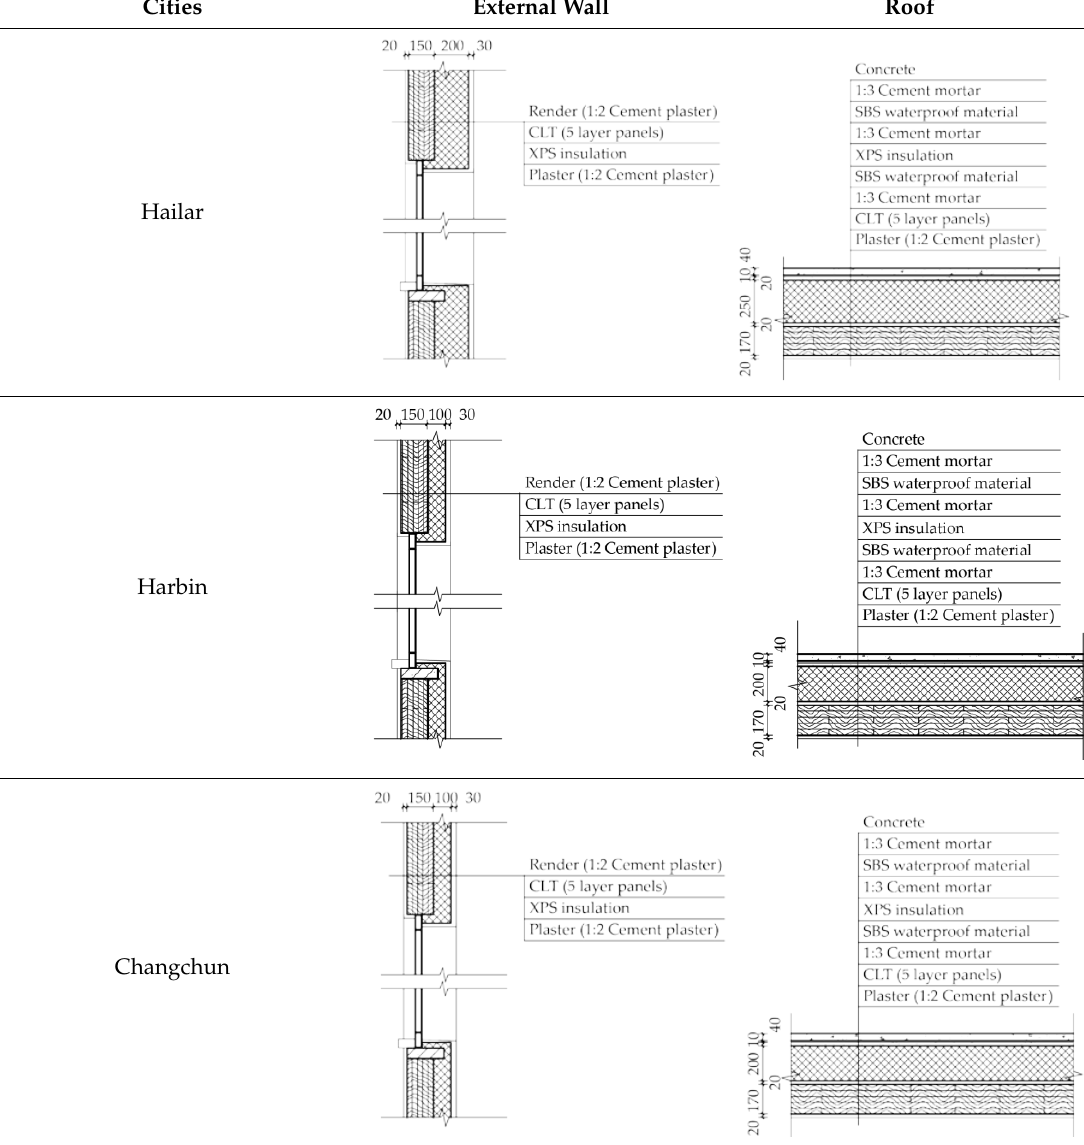
Table 6. External wall and roof designs for the CLT residential buildings in the six cities. Cities